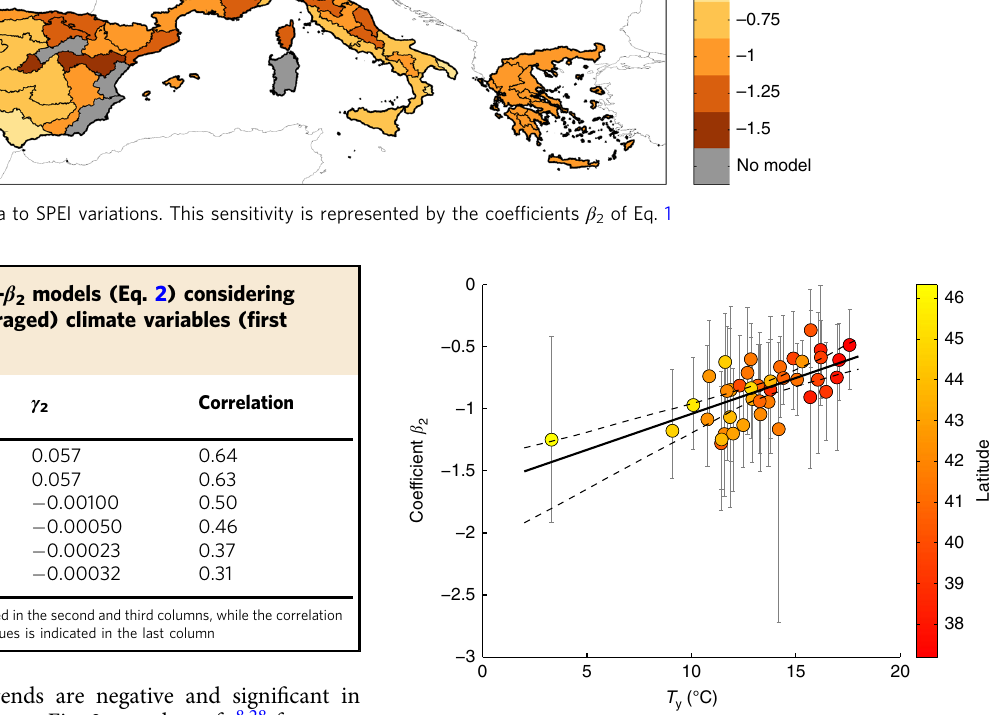
Fig. 2 Relationship between the long-term average of annual temperature ( T y ) versus the sensitivity of burned area to SPEI ( β 2 ) for the different eco- regions. The colours of the points indicate the latitude of the centroid of the sub-region. Grey bars enclose 95% con fi dence intervals of the individual β 2 values. The black line indicates the best linear fi t, while dashed lines indicate the 95% con fi dence interval of the linear regression model of Eq.